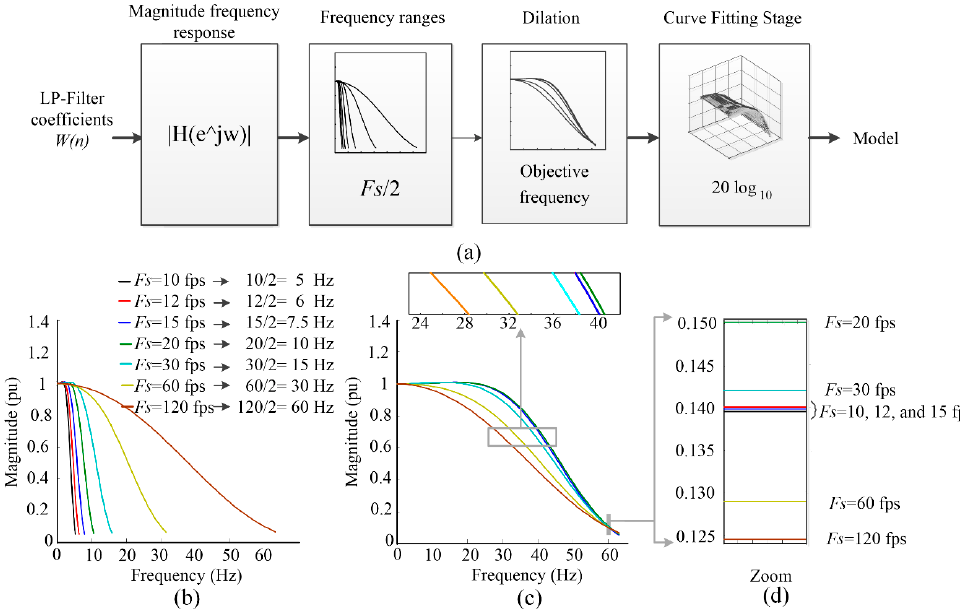
Figure 2. Proposed methodology: ( a ) Flowchart, ( b ) magnitude frequency response, ( c ) Dilated curves and ( d ) Zoom for 10, 12 and 15 dilated curves.